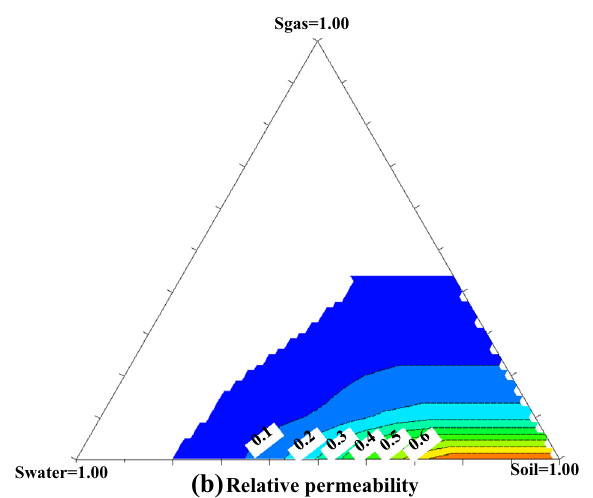
Fig. 6 Comparison of the distributions of temperature when the injec- tion process is